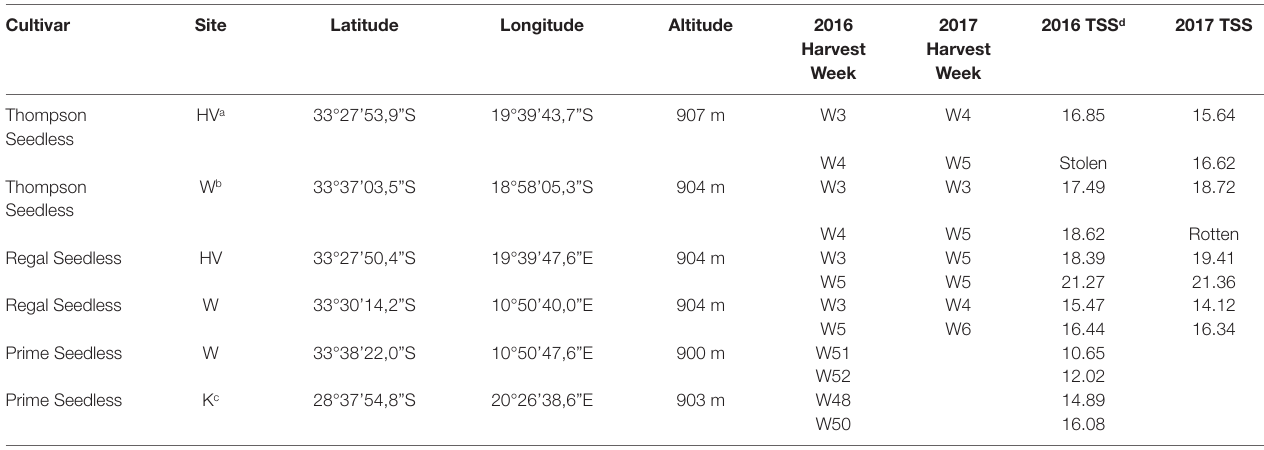
TABle 1 | GPS co-ordinates, harvest week, and TSS level of grapes.